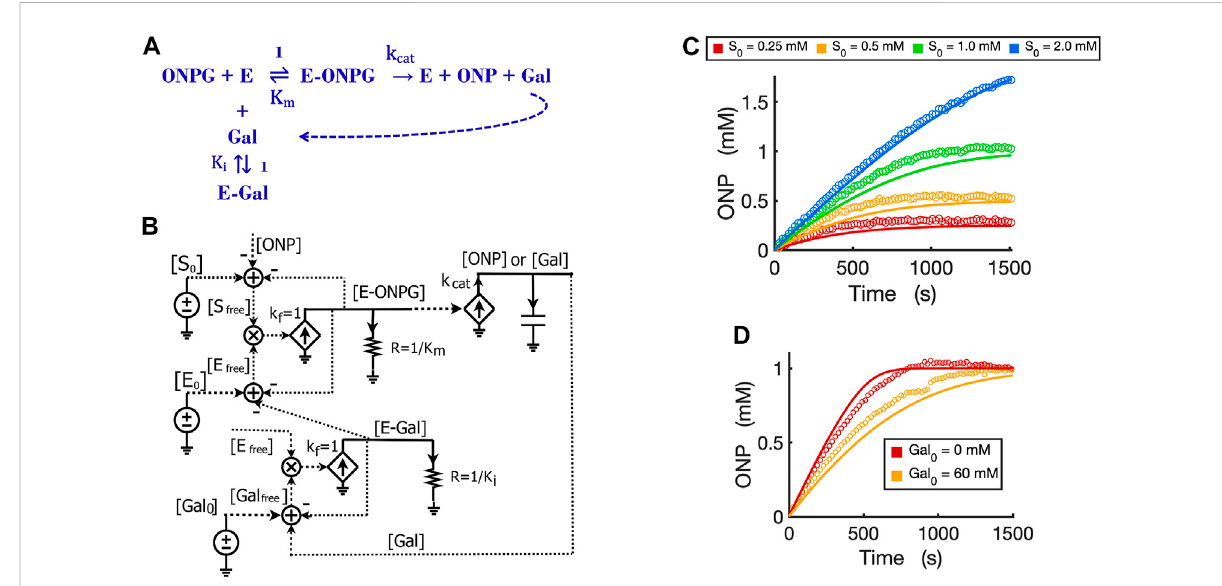
FIGURE 6 Circuitmodelingofproductfeedbackinhibition. (A) Theschemeofproductfeedbackinhibitionbasedoncompetitiveinhibition.Galactose[Gal] is one of the products and is also an inhibitor to the enzyme, beta-galactosidase. (B) The circuit model for product feedback inhibition: [S 0 ] is the initial ONPGaddedto thereactionwhile [Gal 0 ]istheinitial galactose addedto thereaction. (C) Modelcurvesofproductdynamics overtime fi ttedto experimentaldatawithvaryinginitialsubstrateconcentrations(when[Gal 0 ]=40 mM,E 0 =0.7 nM). (D) Modelcurvesofproductdynamics fi tted to experimental data with or without galactose added to the reaction (when ONPG = 1 mM, E 0 = 0.85 nM). All simulation curves are obtained from the circuit model (B) with experimentally measured K i = 13.7 mM, and the same K m and k cat from Figure 4. All data points are means of three independent replicates with standard deviations less than 20% of the corresponding mean (not